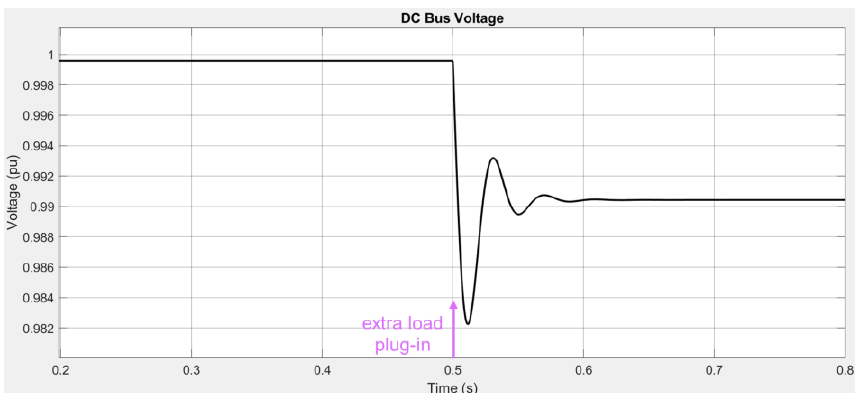
Figure 21. Voltage nadir measured in the equivalent control diagram.